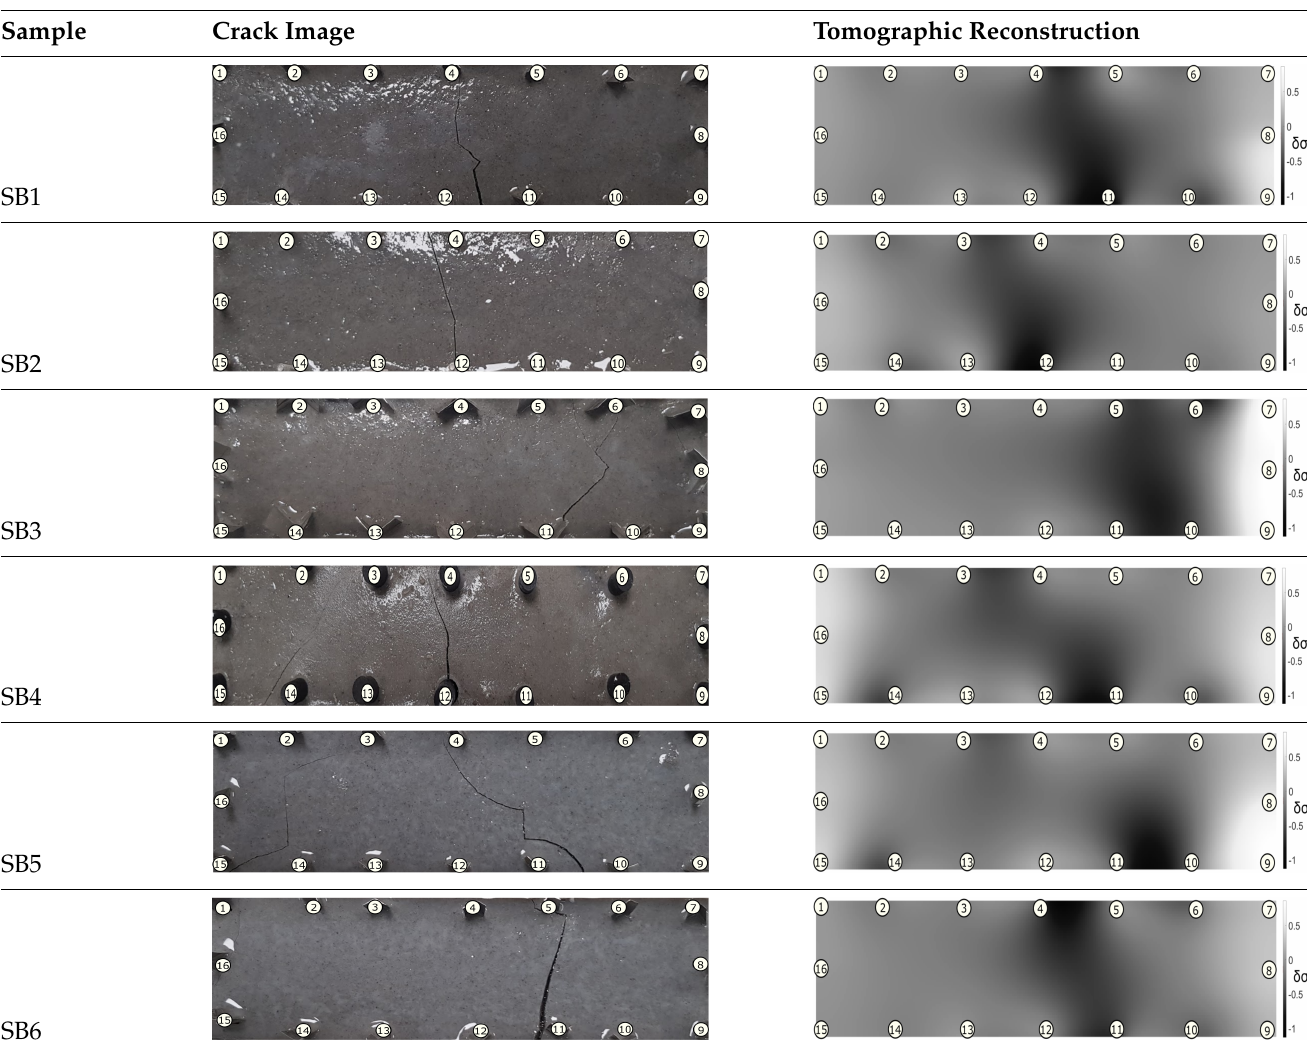
Table 3. Beam sample crack detection and localisation results from tomographic